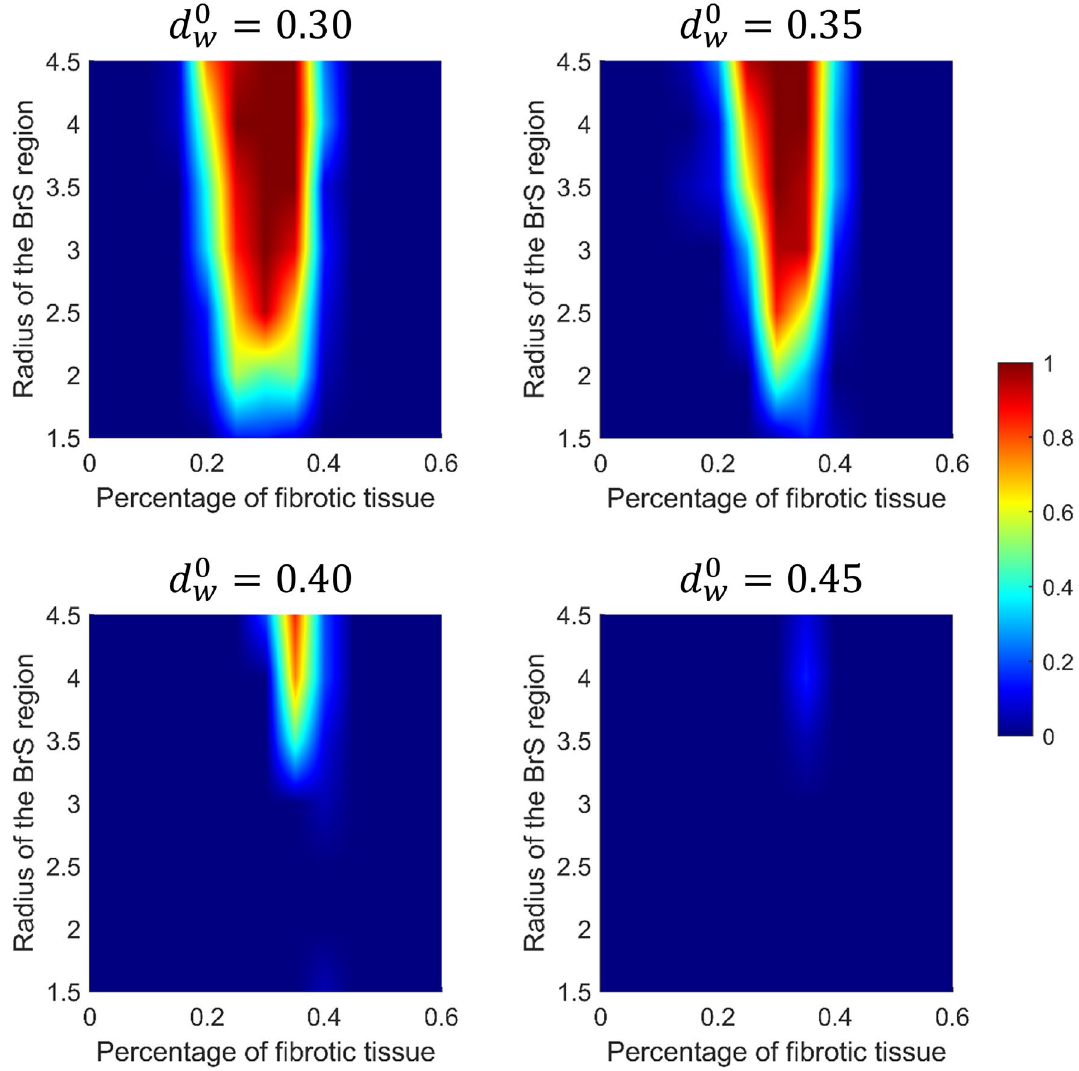
Figure 8. Normalized values of observed sustained re-entries over 20 tissue simulations. The original samples were 13 values of F p and 7 of R B , the images were linearly interpolated in order to better appreciate the behaviour of the model.